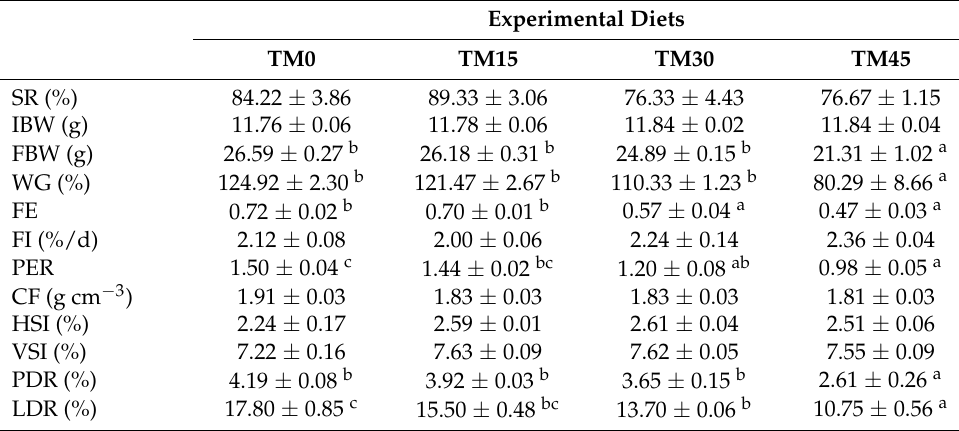
Table 3. Growth, feed utilization, morphological parameters and nutrient depositions of large yellow croakers fed diets with different levels of